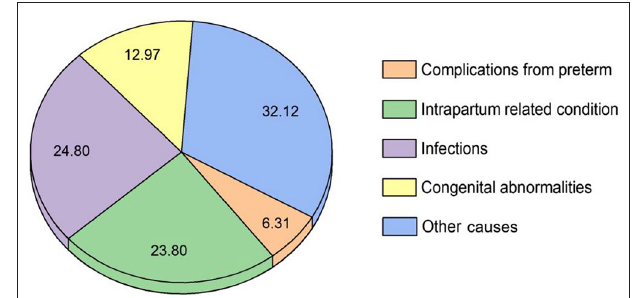
FIGURE 7 | Disease spectrum of infants in the NICU over the study period via WHO classification. Note: The prevalence of neonatal disease is expressed as a percentage (%) of all reported diseases.